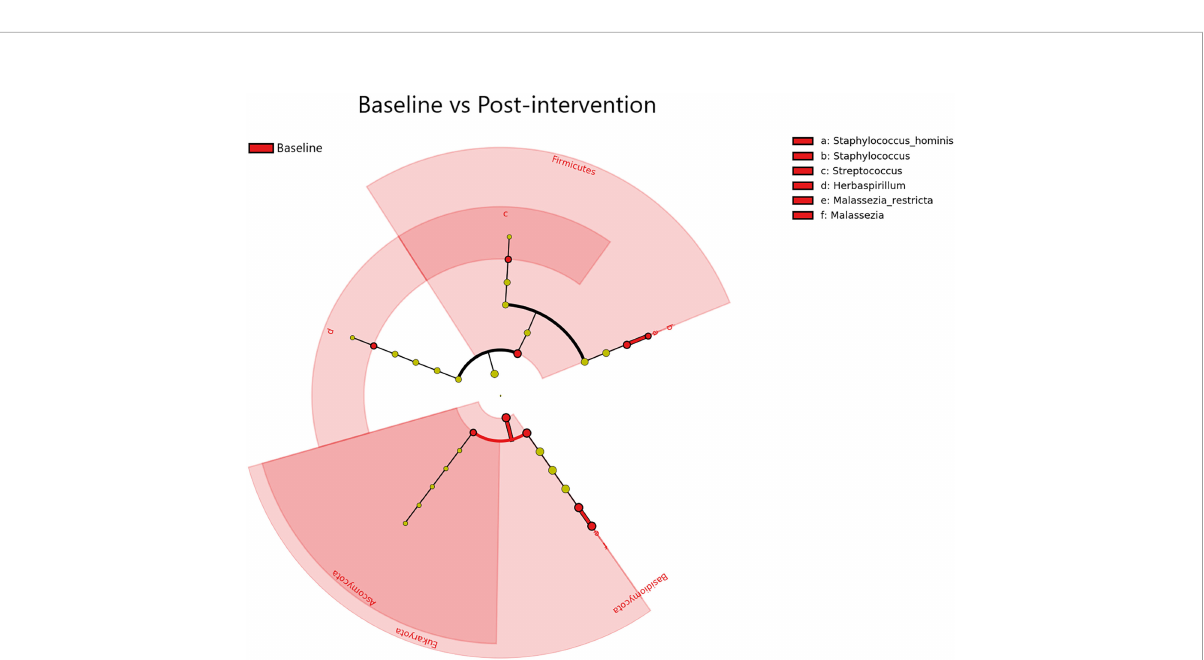
FIGURE 5 Differential Taxa (Domain, Phylum, Genus, and Species levels) identi fi ed by LEfSe Pre- vs Post-AIONX ® cleanSURFACES ® intervention analysis. The taxa shown were signi fi cantly (Kruskal-Wallis, p ≤ 0.05 and log (LDA) ≥ 1.5) more active in Baseline samples. No enriched taxa were identi fi ed in the Post-AIONX ® cleanSURFACES ®